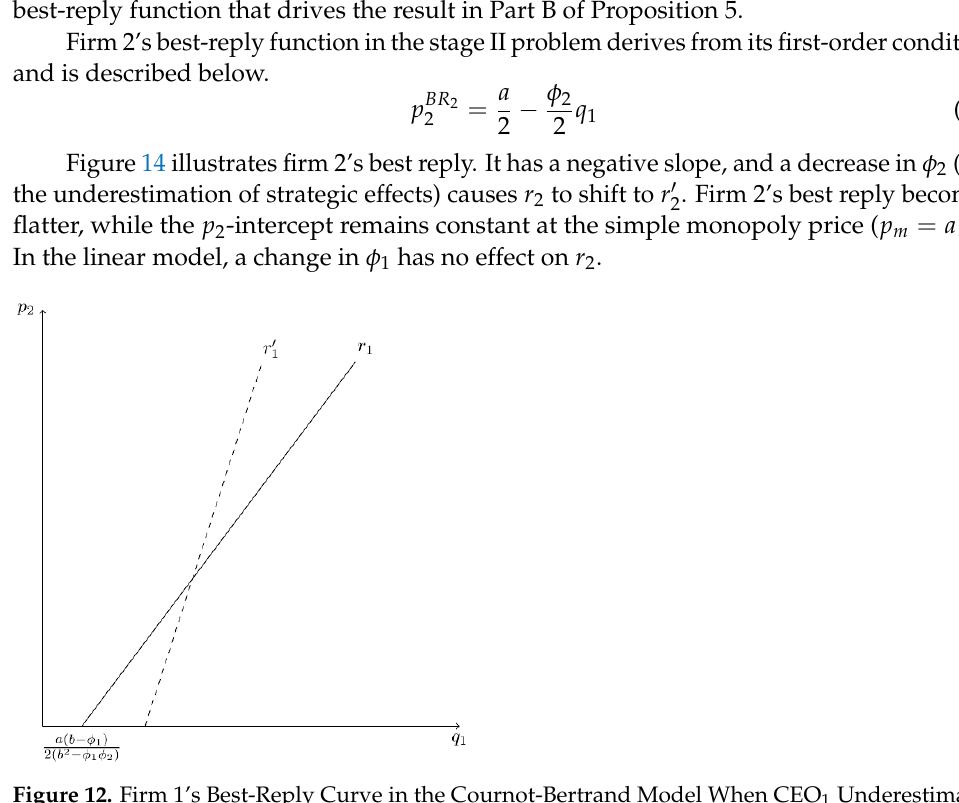
Figure 12. Firm 1’s Best-Reply Curve in the Cournot-Bertrand Model When CEO 1 Underestimates Product Substitutability.